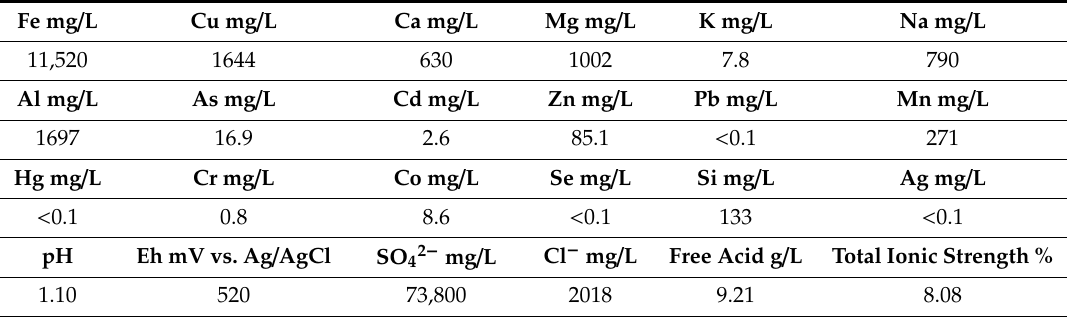
Table 1. Element assay of the acid mine drainage during heap bioleaching.